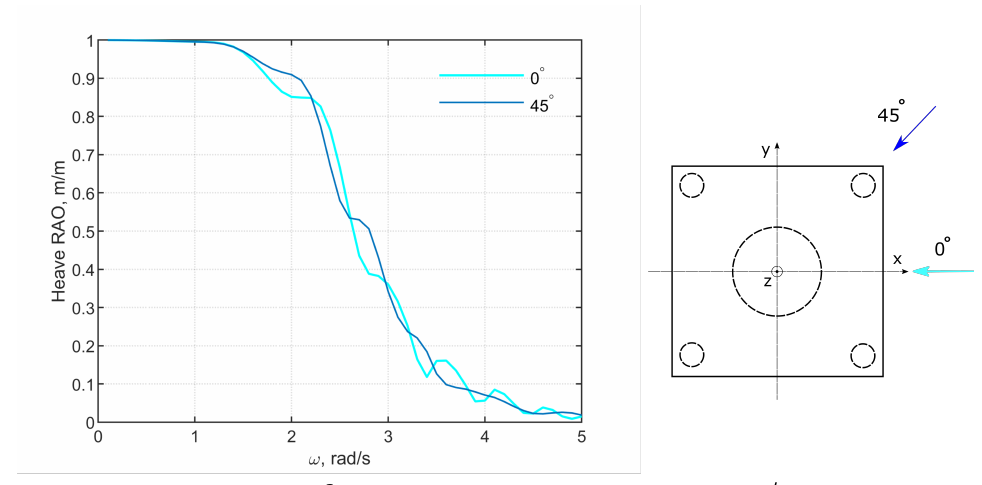
Figure 4. ( a ) Heave RAO of the buoy with a radius of 4 m and four-leg platform for different wave heading angles; ( b ) top view of the buoy and columns’ arrangement relative to the platform, and wave heading angles are indicated.